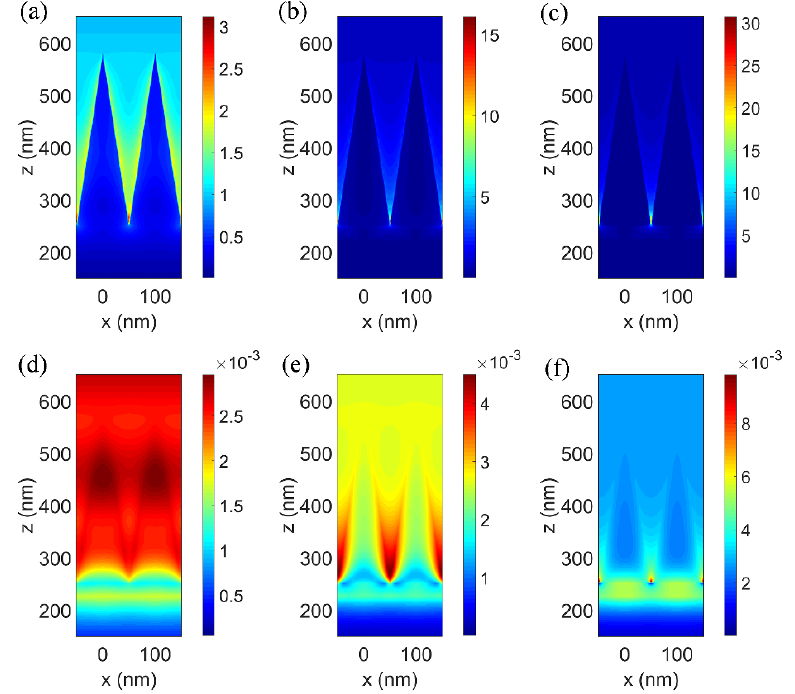
Figure 3. Electric field distributions at wavelengths as ( a ) 400 nm; ( b ) 700 nm; ( c ) 1300 nm and magnetic field distribution at ( d ) 400 nm; ( e ) 700 nm; ( f ) 1300 nm. The units of the electric and magnetic field are V/m and A/m, respectively.